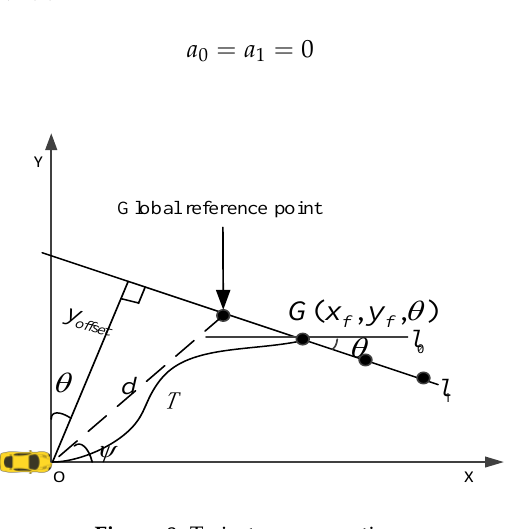
Figure 8. Trajectory generation.